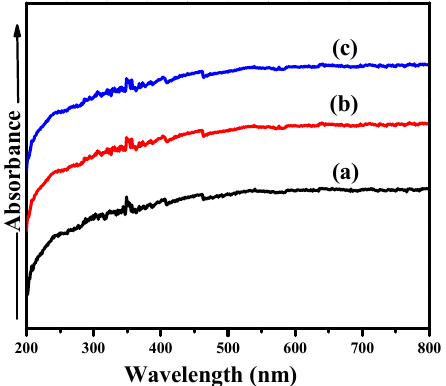
Figure 6. Ultra-violet visible absorbance spectra of ( a ) 1Cu/ZIF-8N2 ( b ) 2Cu/ZIF-8N2 ( c ) 3Cu/ZIF-8N2.